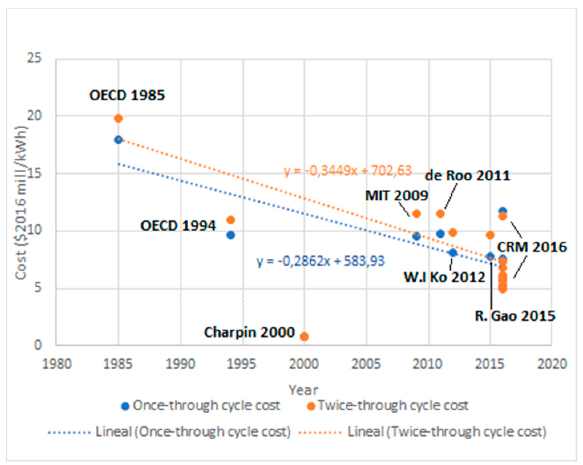
Figure 1. Evolution of nuclear fuel cycle costs.